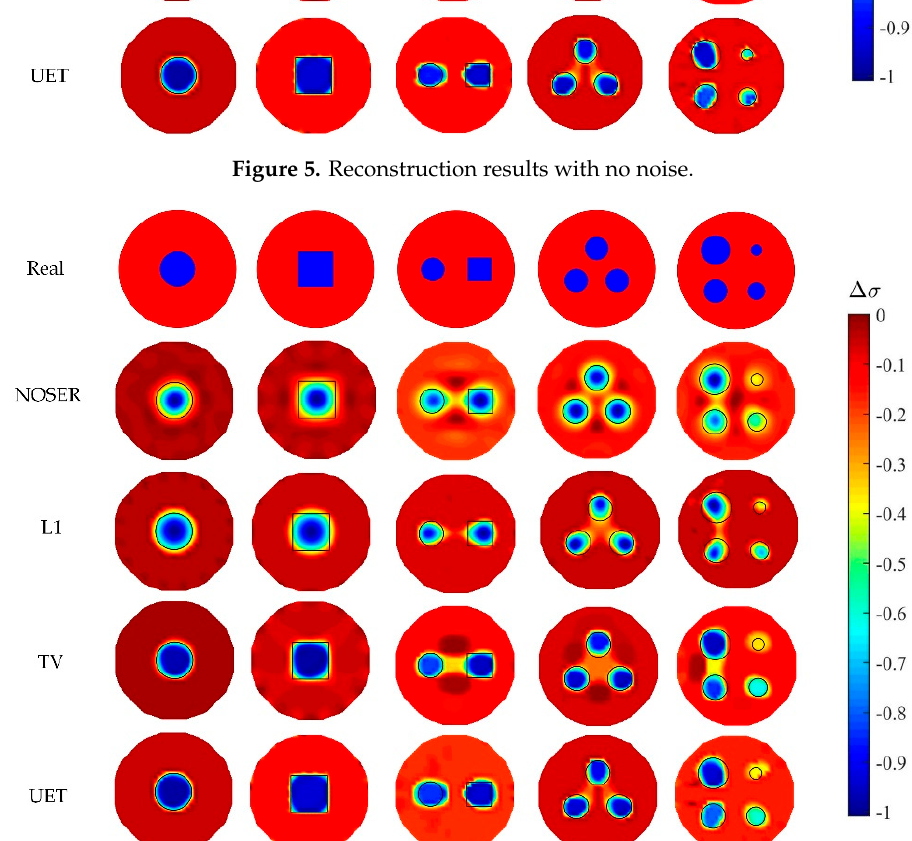
Figure 6. Reconstruction results with 40 dB noise.